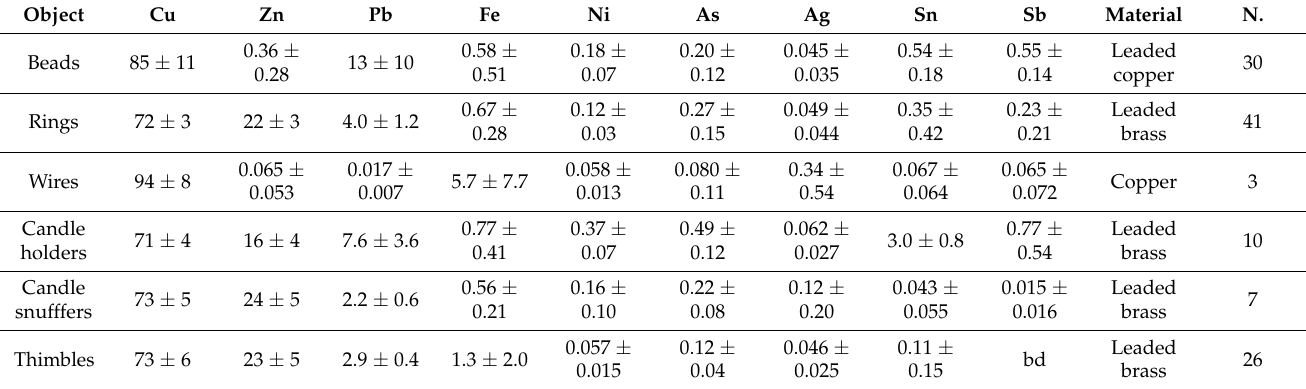
Table 1. Average chemical composition ( µ XRF, g/100 g, normalised) of the copper alloy artefacts from the Rooswijk (bd = below detection). N. indicates the number of analysed artefacts per